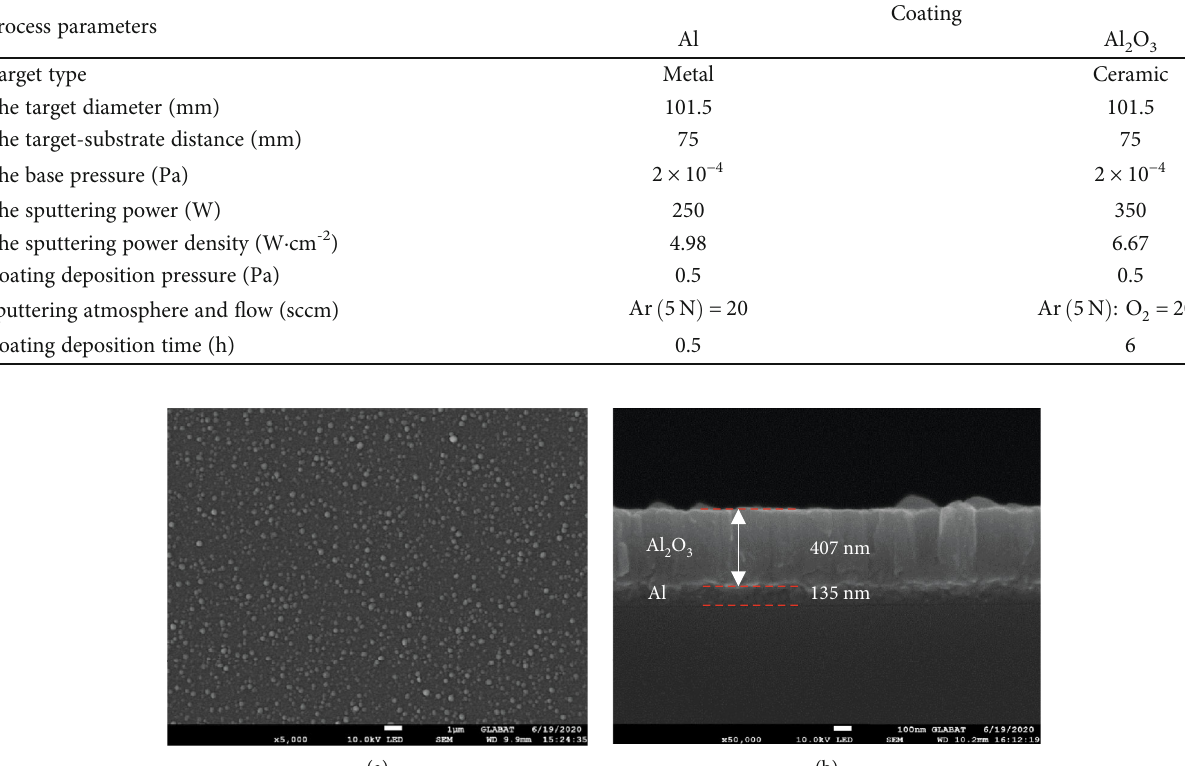
O coating in depth element 2 3